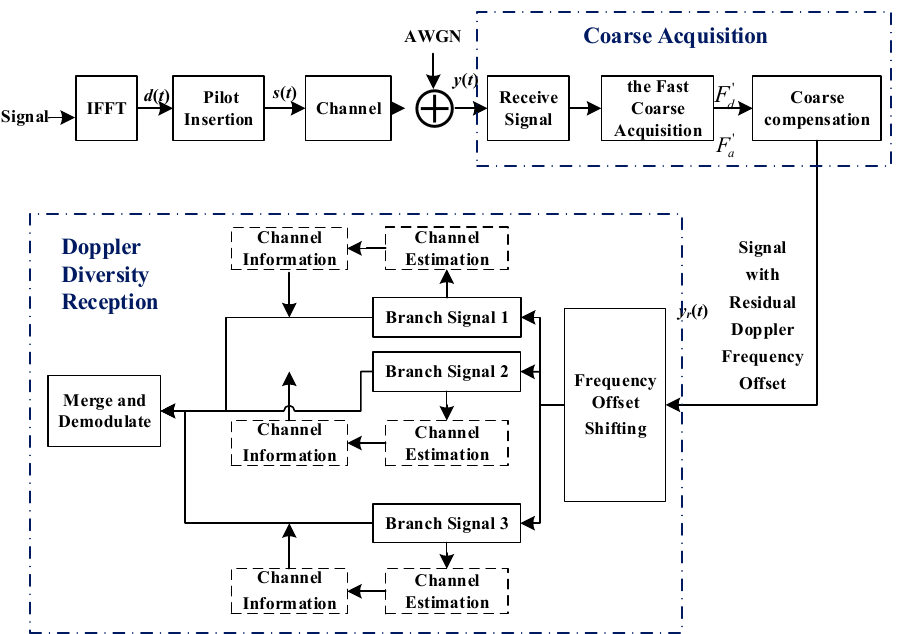
Figure 1. Overall framework of fast telemetry and communication based on Doppler diversity.